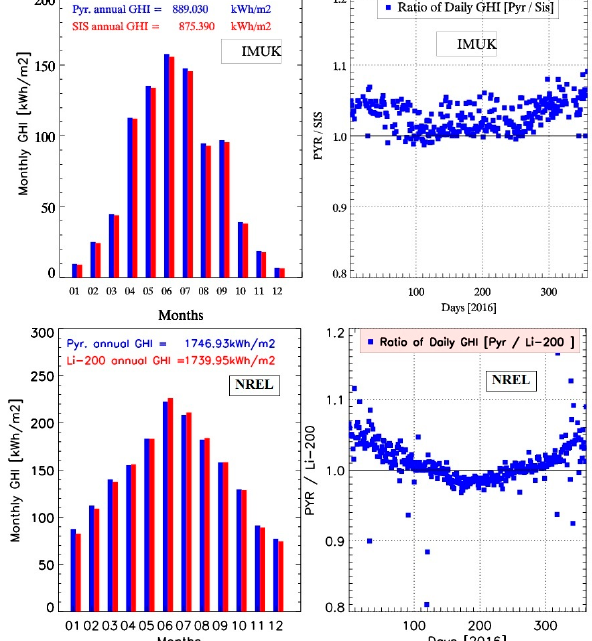
Figure 3. [ Top plots ] Monthly global horizontal irradiance (GHI) measured by thermopile pyranometers and silicon sensors (SiS) on horizontal surface ( left ) and the ratios of daily irradiances measured by both sensors ( right ), for the location of IMuK. [ Bottom plots ] the same as the top plots but at NREL. The irradiance measured by silicon sensors shows an increase during the summer months.